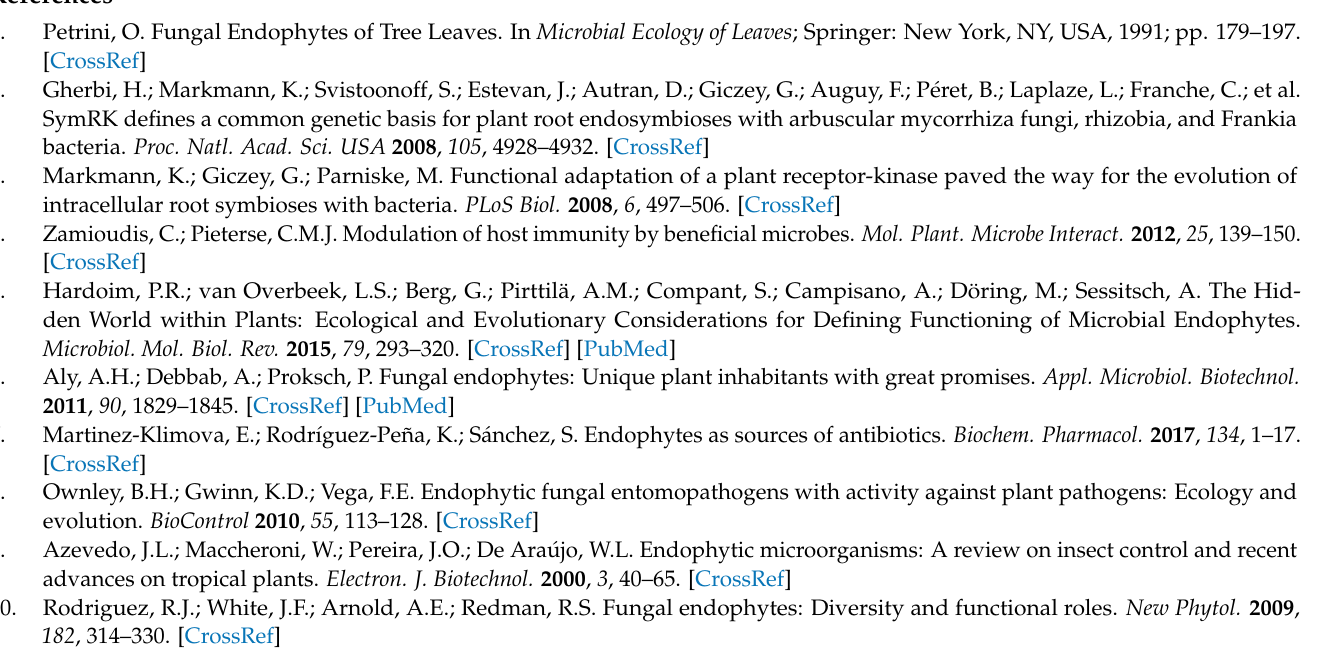
(PERMANOVA) between different environmental factors found in all sampling sites. Table S4. Sum- mary of 144 OTUs isolated from three tissues. Figure S1: Scatter plots showing relationships between species richness and the factors of sampling sites. Figure S2: Scatter plots showing relationships between Shannon’s index and the factors of sampling sites. Figure S3: Relative abundance of Trophic mode in Pinus species (A) P. rigida , (B) P. densiflora , (C) P. thunbergii , and (D) P. koraiensis . Blue, green and pink bars mean root, stem, and needle, respectively. The data were analyzed by employing the analysis of variance and Tukey’s test ( p < 0.05) using R version 3.6. Significance codes: 0 ***, 0.001 **, 0.01 *. Figure S4: Relative abundance of Fungal Guild in Pinus species (A) P. rigida , (B) P. densiflora , (C) P. thunbergii , and (D) P. koraiensis . Blue, green and pink bars mean root, stem, and needle respectively. The data were analyzed by employing the analysis of variance and Tukey’s test ( p < 0.05 ) using